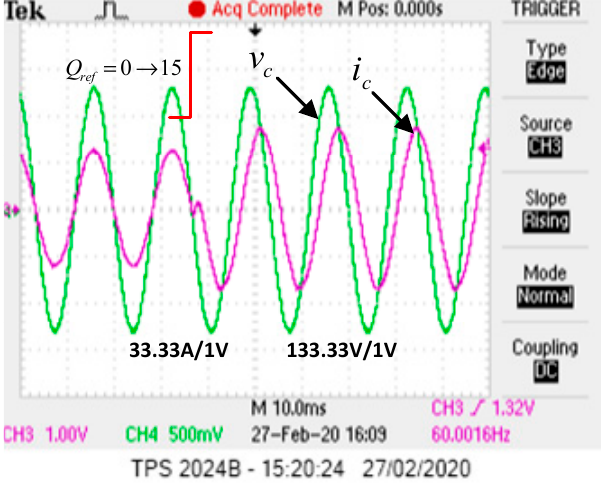
Figure 17. Voltage and current for phase C during Pref = 10 kW and transition from Qref = 0 to Qref = 15 kVar.